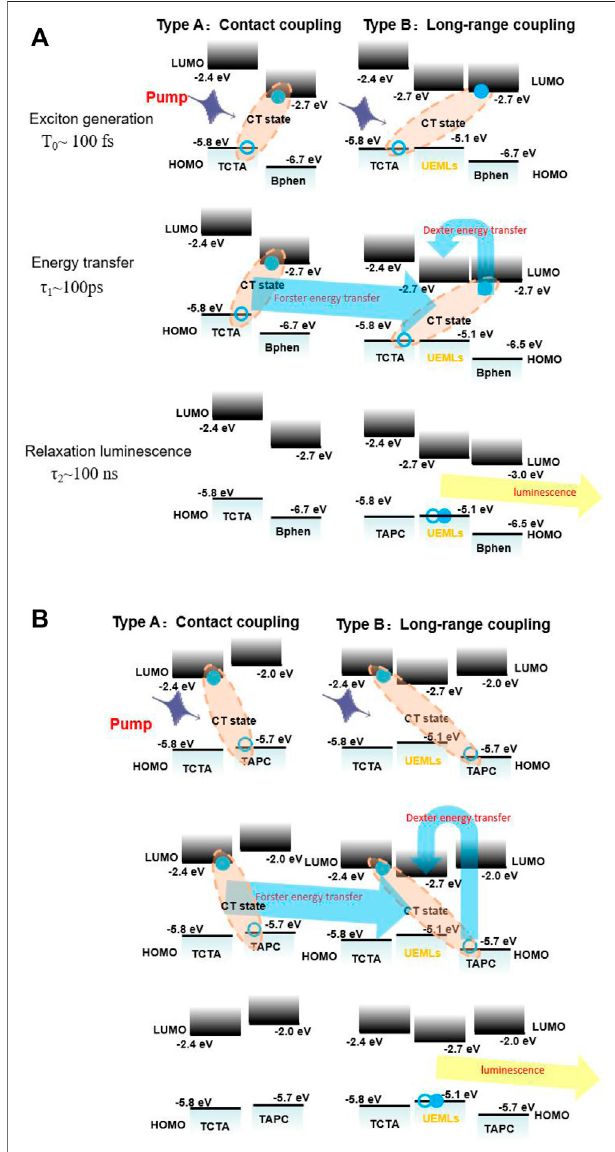
FIGURE 2 | Energy transfer process of ultrathin emitting nanolayers within the exciplex interface (A) TCTA/Bphen and the non-exciplex interface (B)